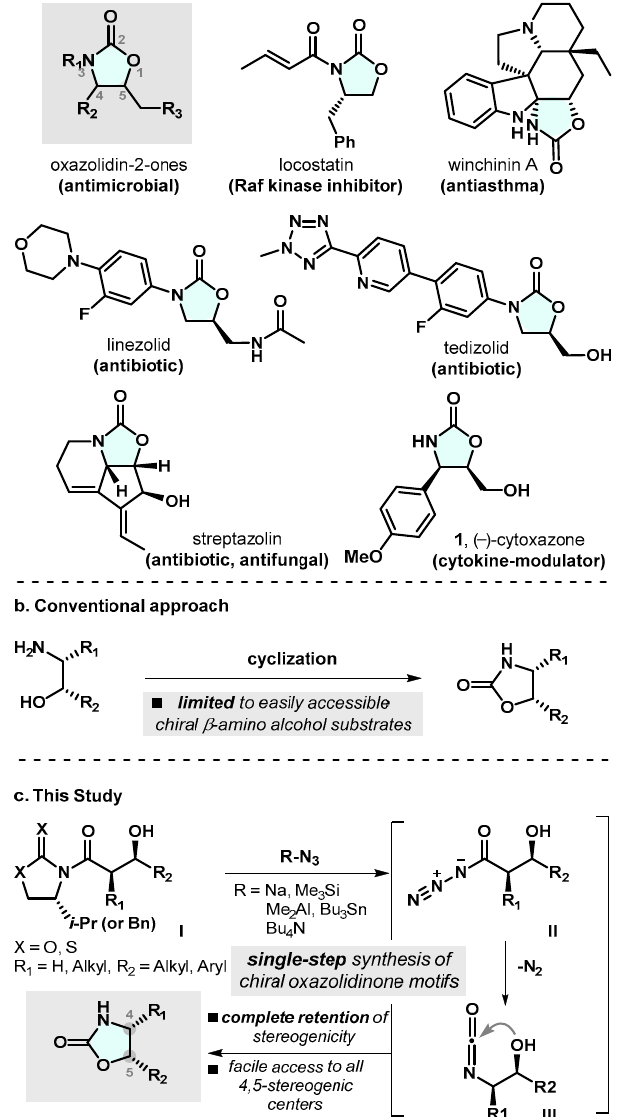
Scheme 1. ( a ) Natural products and pharmaceuticals containing oxazolidin-2-ones ( b ) Conventional method towards the oxazolidin-2-ones ( c ) Proposed Strategy for the synthesis of the 4,5-disubstituted oxazolin-2-one framework.